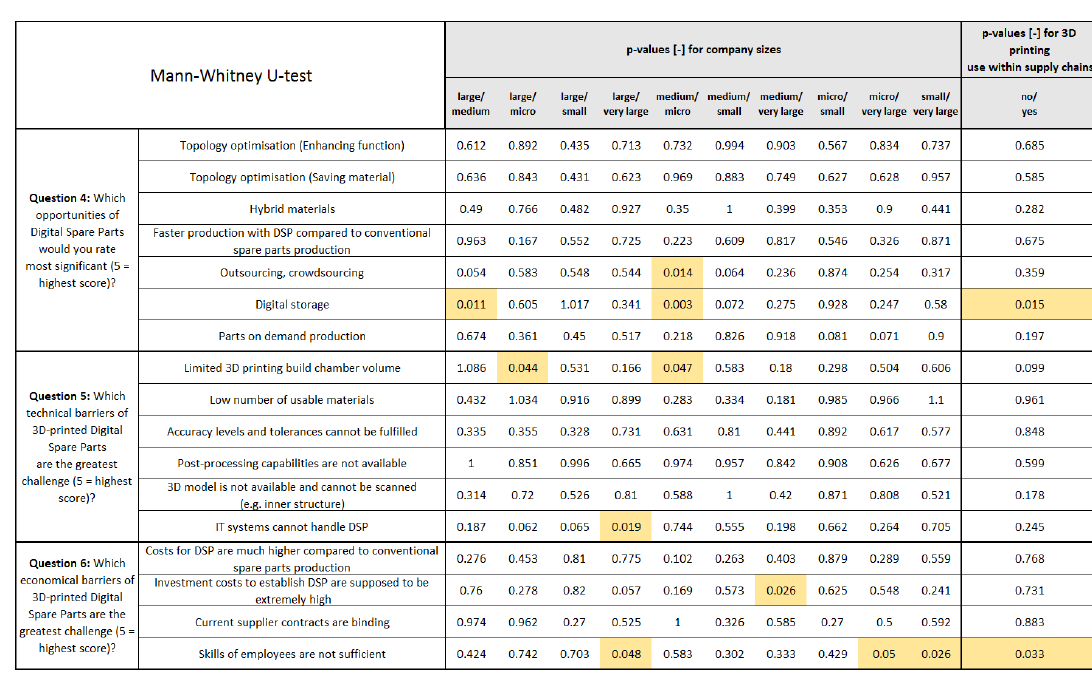
Table A1. List of survey questions.